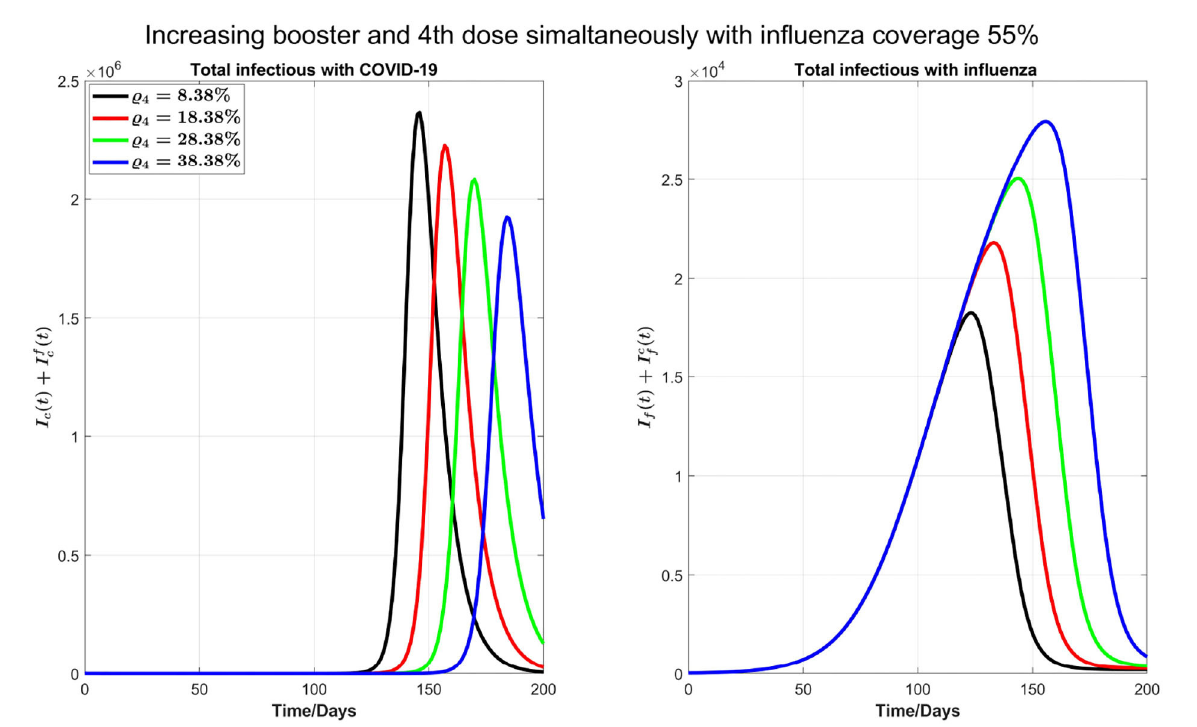
FIGURE7 Impact of increasing coverage of COVID-19 booster (third) and fourth doses simultaneously with 55% influenza vaccine coverage on COVID-19 and influenza